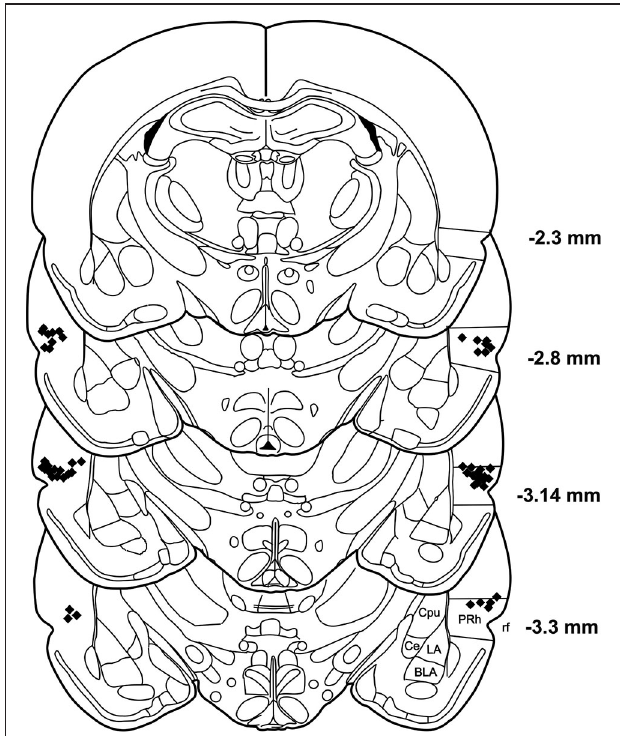
FIGURE 2 | Histological reconstructionof coronal sections of the rat brain showing the injection sites in the PRh . BLA: basolateral amygdaloid nucleus, Ce: central amygdaloid nucleus, Cpu: caudate putamen, LA: lateral amygdaloid nucleus, PRh: perirhinal cortex, rf: rhinal fissure.